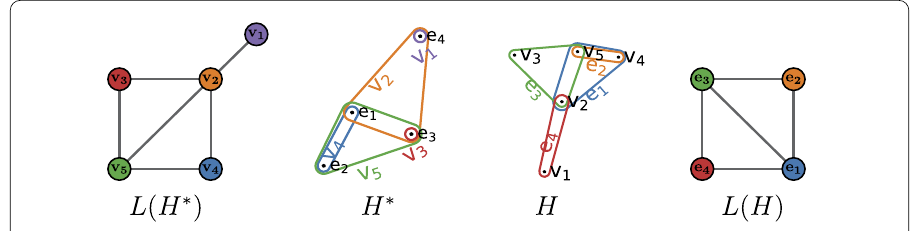
Figure 2 From left to right: the line graph of H ∗ , the hypergraphs H ∗ and H , and the line graph of